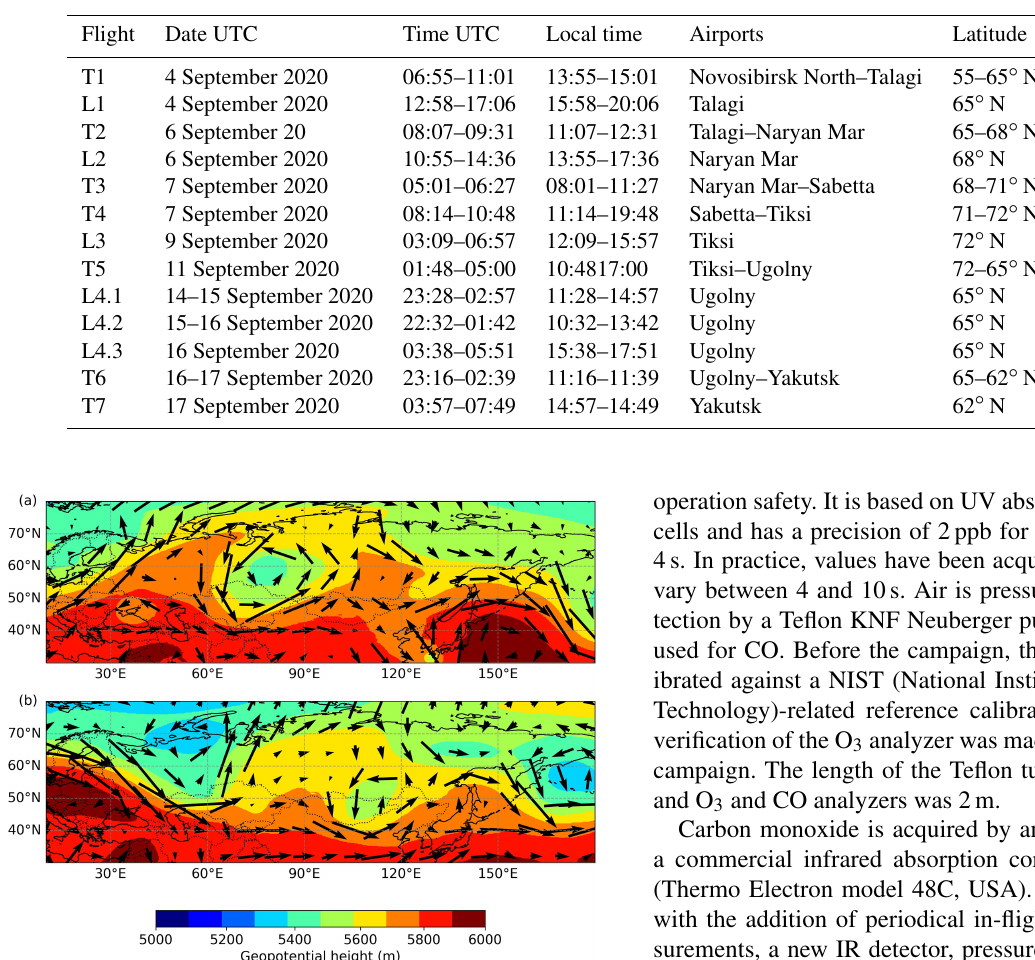
Table 1. Campaign description.